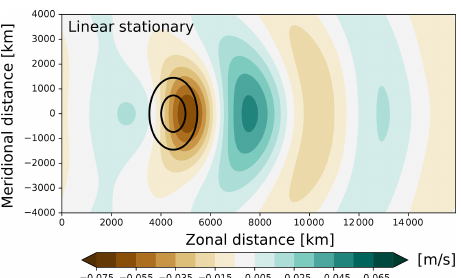
Figure 8. Linear quasi-geostrophic solution of the stationary Rossby wave response to isolated orography. Shading and contours are the same as in Fig. 7 except that the meridional wind is shown at z =